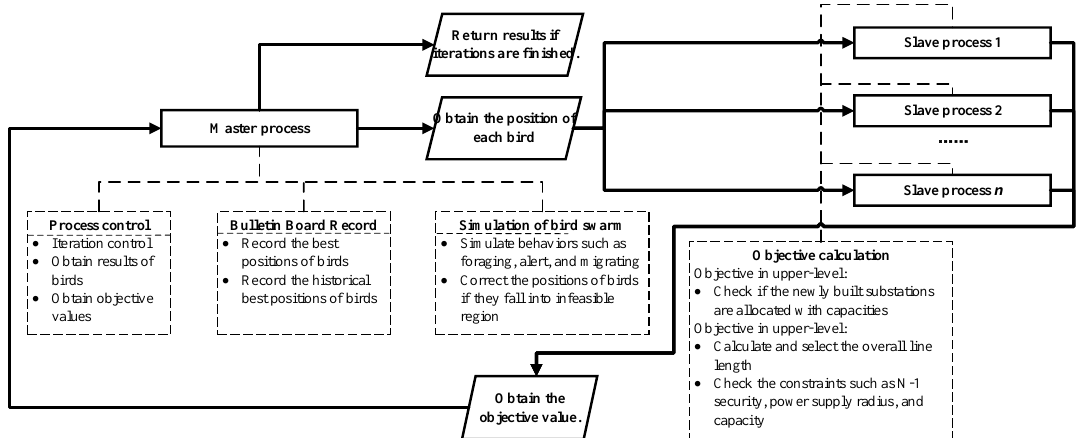
Figure 3. Flow chart of the master-slave architecture based parallel BSA for joint planning of substations and lines in distribution systems.